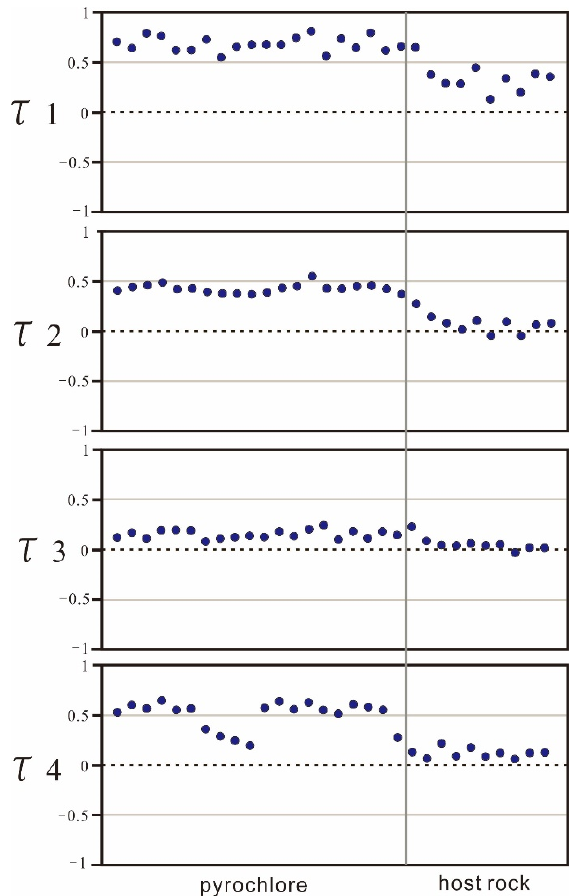
Figure 10. Tetrad τ coefficients for pyrochlore supergroup minerals and their host rocks. The first to fourth tetrad coefficients are shown, respectively.